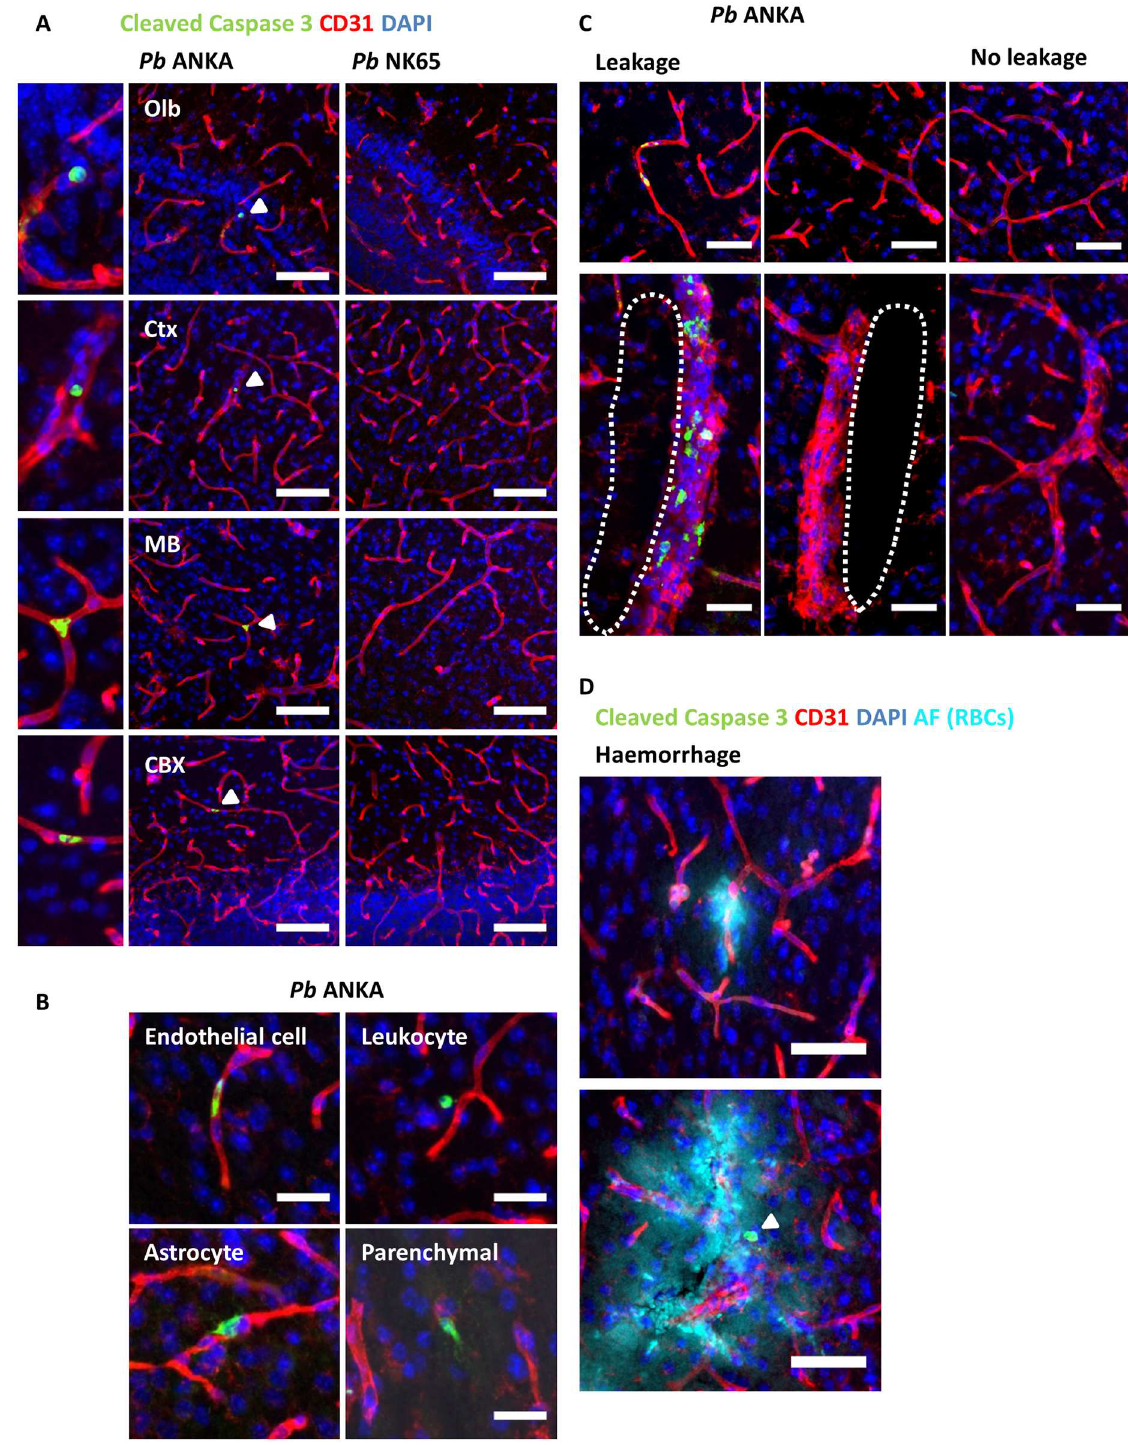
Fig 7. Vascular leakage occurs independently of endothelial cell apoptosis. C57BL/6 mice were infected with 1x10 4 Pb ANKA GFP (n = 4) or 1x10 4 Pb NK65 GFP (n = 4) pRBCs. Mice were culledat d7 p.i. when Pb ANKA infected mice exhibitedsigns of late-stage ECM. Brains were removedfrom transacardially perfusedmice and examinedvia immunofluorescencefor the presenceof cleavedCaspase 3 (Green) in relationto lectin-labelled vasculature and macrophages (red), with nuclei counterstained blue. (A) Representative immunofluorescent images demonstrating the degreeof cellularapoptosisin the